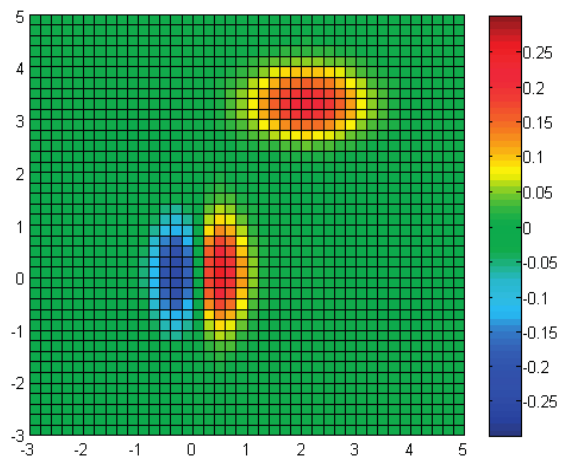
Figure 10. Environment model: 2D plot with color map.